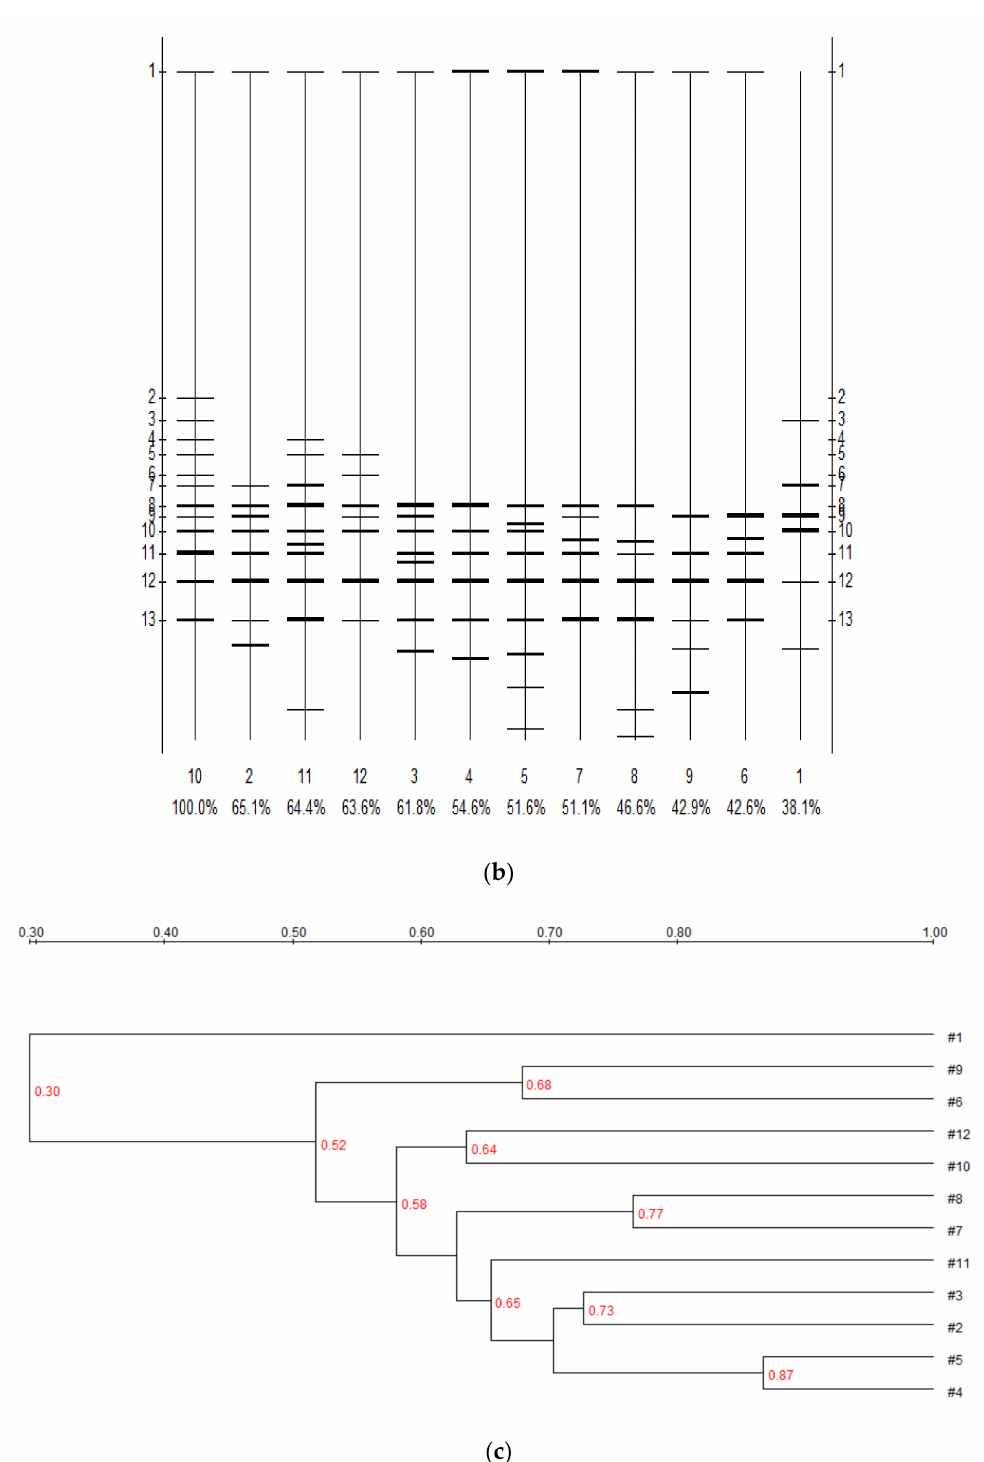
Figure 7. Fingerprint of DGGE in the soil with the same treatments and different times. ( a ) DNA electrophoresis fingerprint of DGGE; ( b ) diagram of compare lane images; ( c ) UPGAMA of phylo- genetic tree. 10-1~10-3: S + D-10, S + D + B-10, S + G + D + B-10; 30-1~30-3: S + D-30, S + D + B-30, S + G + D + B-30; 90-1~90-3: S + D-90, S + D + B-90, S + G + D + B-90; 210-1~210-3: S + D-210, S + D + B-210, S + G + D +